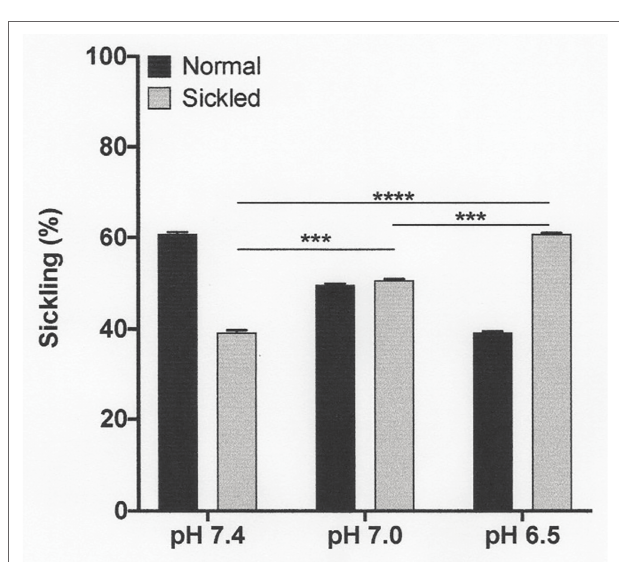
FIGURE 3 | Effect of pH on sickling of deoxygenated red cells from patients with SCA. Red cells (1% haematocrit, Hct) were incubated in Eschweiler tonometers at 37 o C and an osmolality of 290 mOsm.kg-1 for 15 min under fully deoxygenated conditions (0 mmHg oxygen) at three different extracellular pH values, pH 7.4, 7.0, and 6.5. Red cell aliquots were then removed and fixed using 0.3% glutaraldehyde whilst maintaining the same pH present during their incubation. Histograms represent means ± SEM, n = 3. *** p < 0.001; and **** p < 0.0001, comparing red cells in the absence of urea with those in its presence.